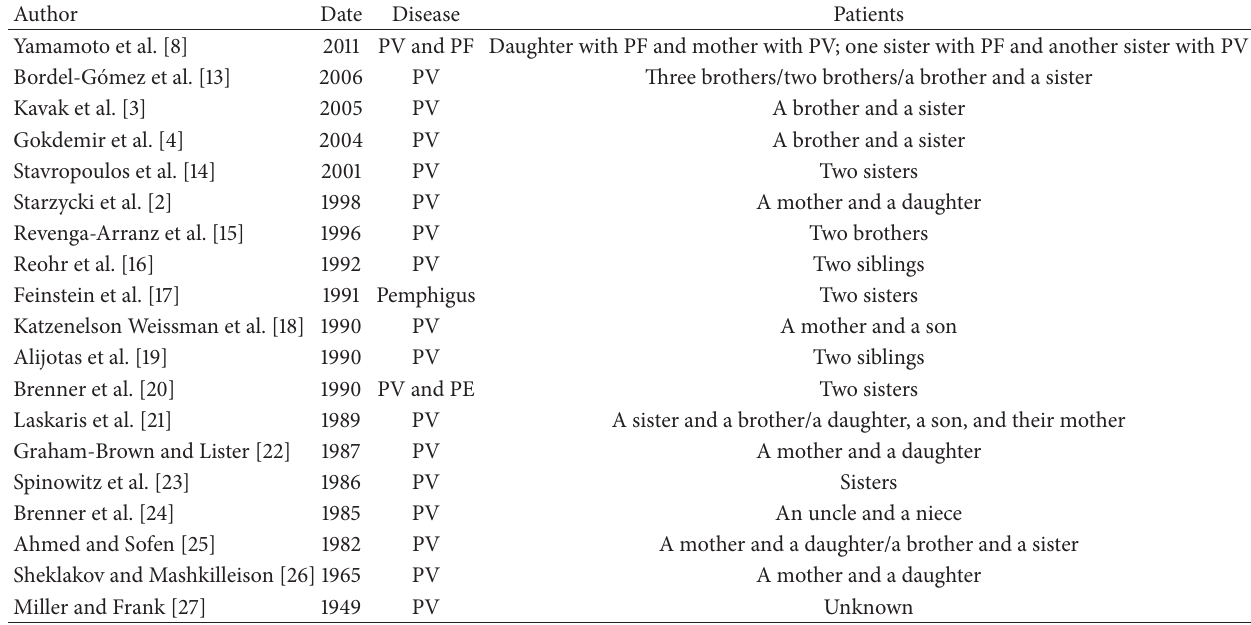
Table 1: Familial pemphigus vulgaris cases found in the PubMed database. PE: pemphigus erythematosus, PF: pemphigus foliaceus, and PV: pemphigus